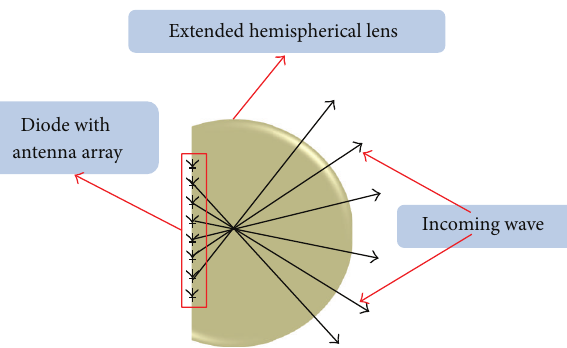
Figure 1: Dimensions of the antiparallel Schottky diode chip. The airbridges are approximately 19 𝜇 m long. The chip is supported on GaAs substrates [15].